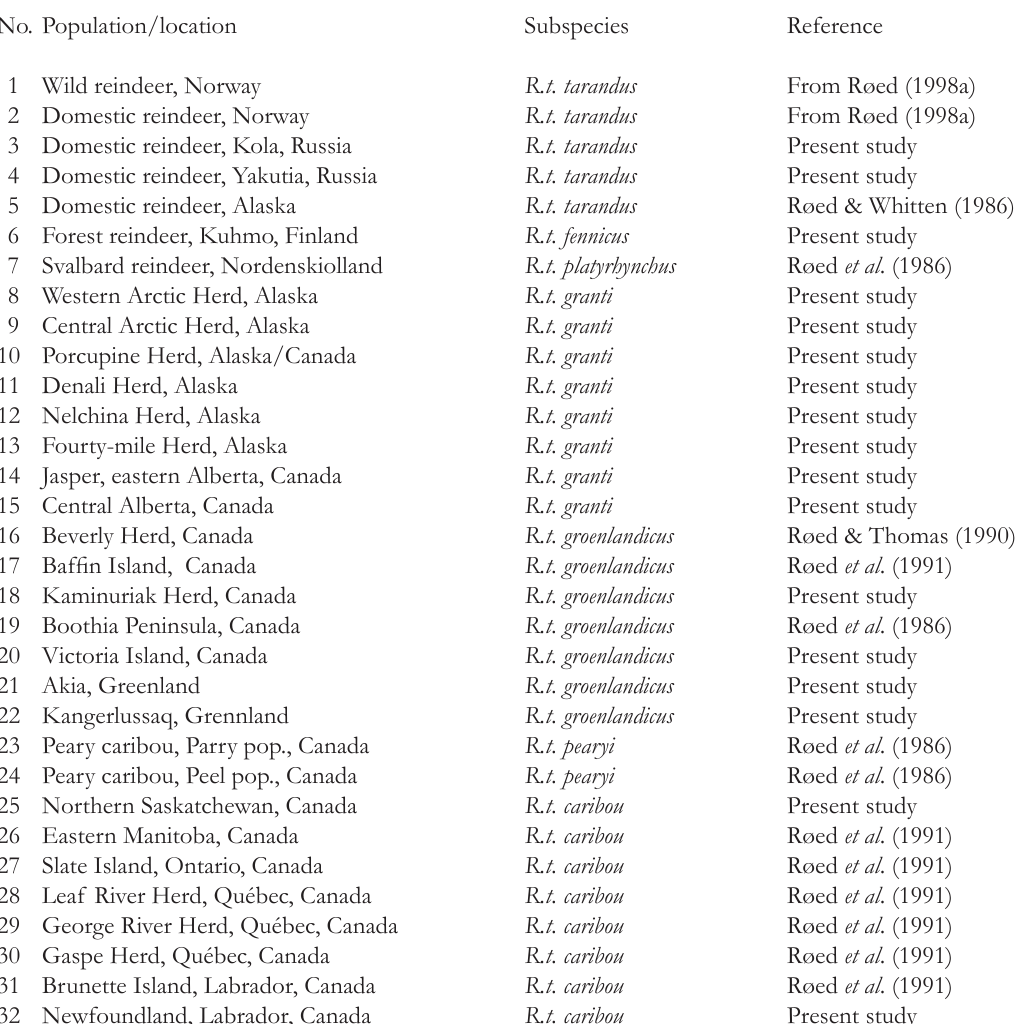
Table 1. Populations of reindeer and caribou analysed for serum transferrin polymorphism. The numbers quote the geographic locations of the population provided in Fig.